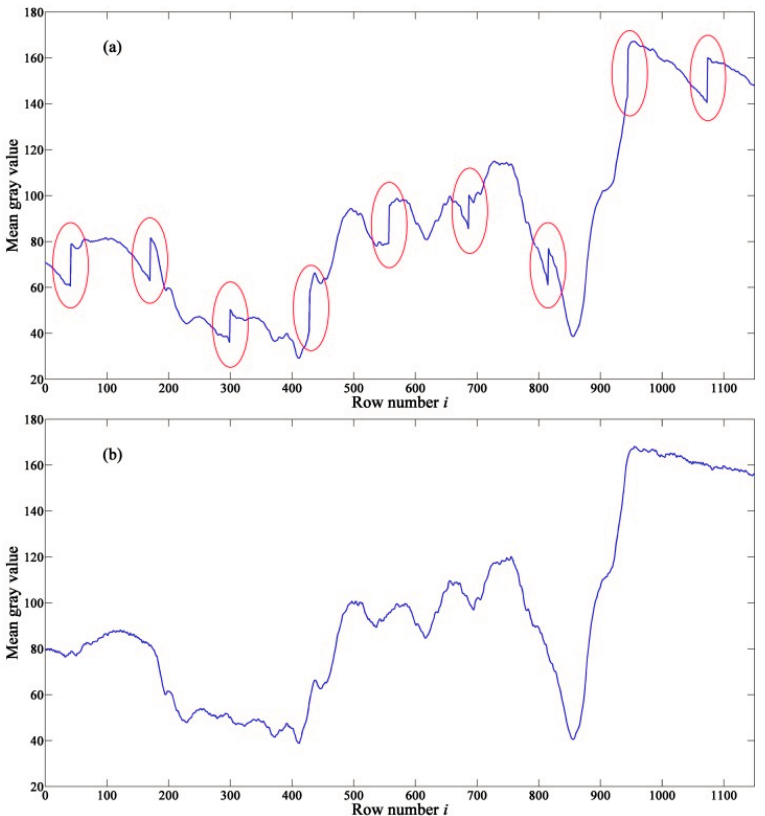
Figure 15. Comparison of row-mean curve of the real-test image in Figure 14. ( a ) Original curve; ( b ) Corrected